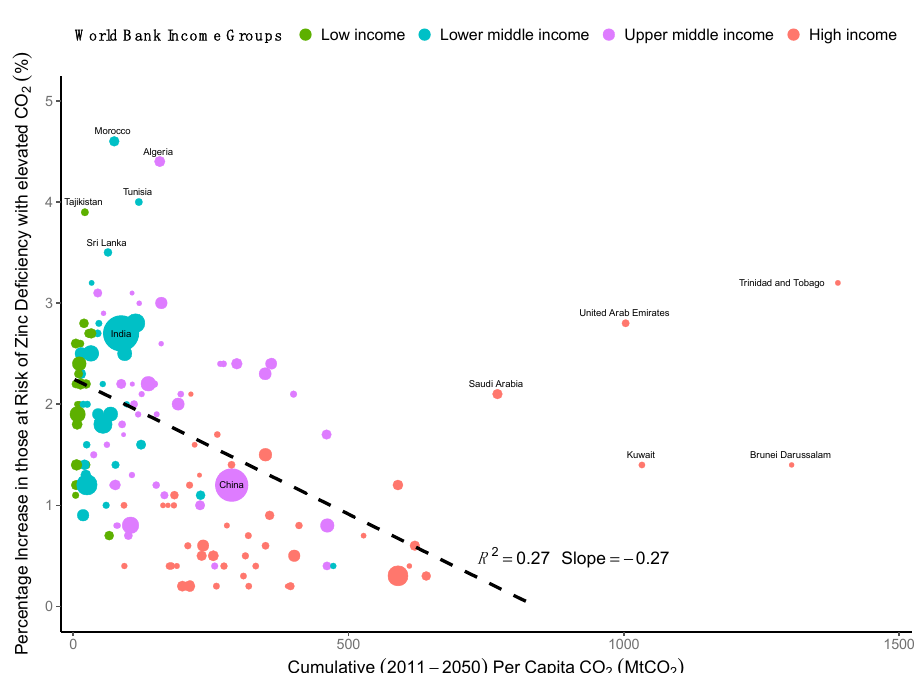
R 2 = 0.27 Slope = − 0.27